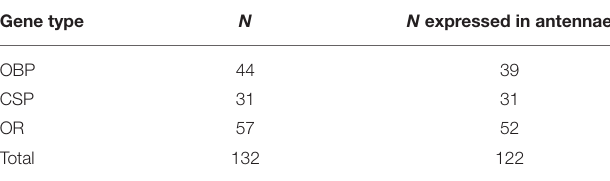
TABLE 1 | Number of Olfactory genes found in T. cristinae